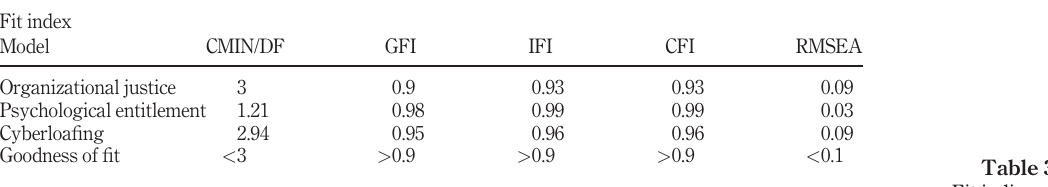
Table 3. Fit indices of